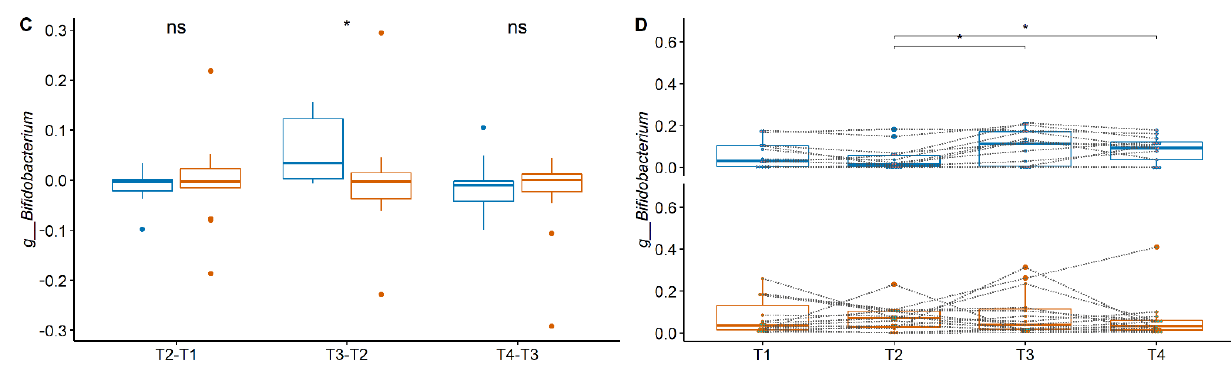
Figure 2. Bacterial taxa that are differentially abundant between the two groups. ( A ) Differences in relative abundances between two consecutive timepoints for the genus Holdemanella . ( B ) The relative abundances of the genus Holdemanella through time within the two groups. ( C ) Differences in relative abundances between two consecutive timepoints for the genus Bifidobacterium . ( D ) The relative abundances of the genus Bifidobacterium through time within the two groups. The boundaries of the box on the bottom indicate the 25th percentile, and the line within the box represents the median, and the boundary of the box on the top the 75th percentile. For panels ( A , C ), the differences between groups were calculated using Mann ‐ Whitney test. For panels ( B , D ), the differences through time were calculated using the paired Wilcoxon Rank test, and data from individual participants are connected by dotted lines. Stars above bars represent statistical differences compared to the time-matched control samples (* p < 0.05).